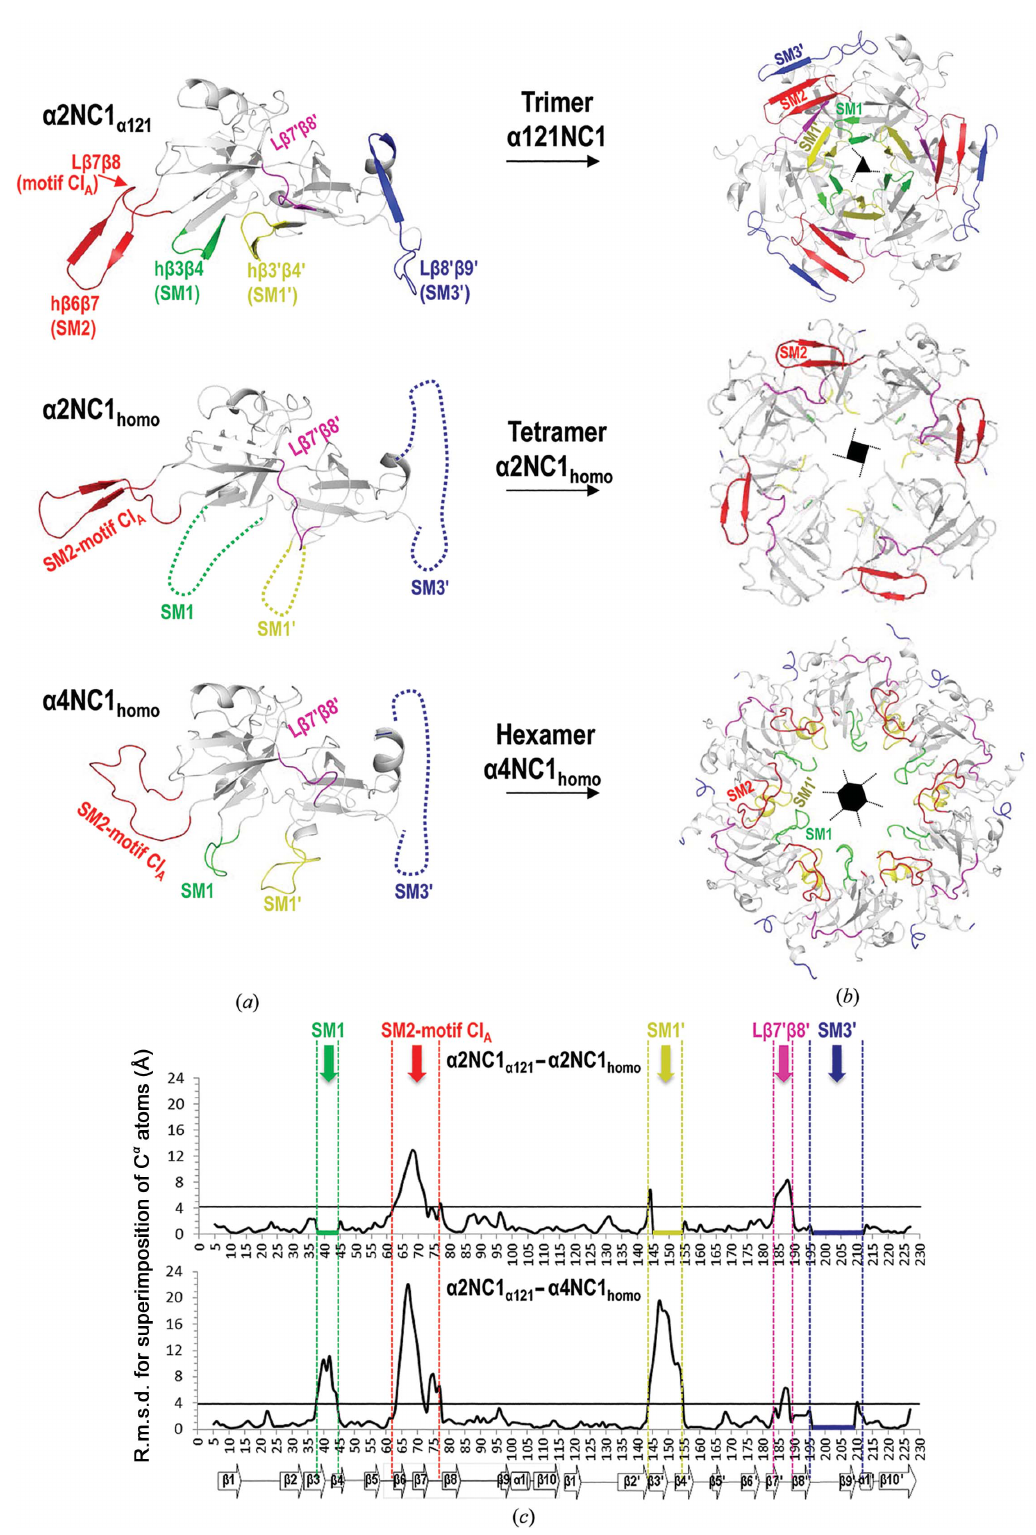
Figure 3 Structural comparisons of (cid:2) 2NC1 (cid:2) 121 , (cid:2) 2NC1 homo and (cid:2) 4NC1 homo . The same colour scheme is used in the three panels. ( a ) Comparison of the (cid:2) 2NC1 and (cid:2) 4NC1 subunits in these oligomers, highlighting the regions with the greatest conformational difference in comparison to (cid:2) 2NC1 (cid:2) 121 . Important structural motifs (SMs; see text) are labelled and coloured. Dashed lines represent highly disordered regions that are not visible in the crystal structures. ( b ) Cartoon representation of the structures of an (cid:2) 121NC1 protomer and the corresponding noncanonical (cid:2) 2NC1 homo and (cid:2) 4NC1 homo tetrameric and hexameric protomers. ( c ) Plot of r.m.s.d. deviation per C (cid:2) atom along the sequences between (cid:2) 2NC1 (cid:2) 121 and (cid:2) 2NC1 homo (top) and (cid:2) 4NC1 homo (bottom). Dashed vertical lines enclose the structural motifs (identified with arrows) showing high r.m.s.d.s. The thick horizontal line (residues 196–210) indicates a lack of electron